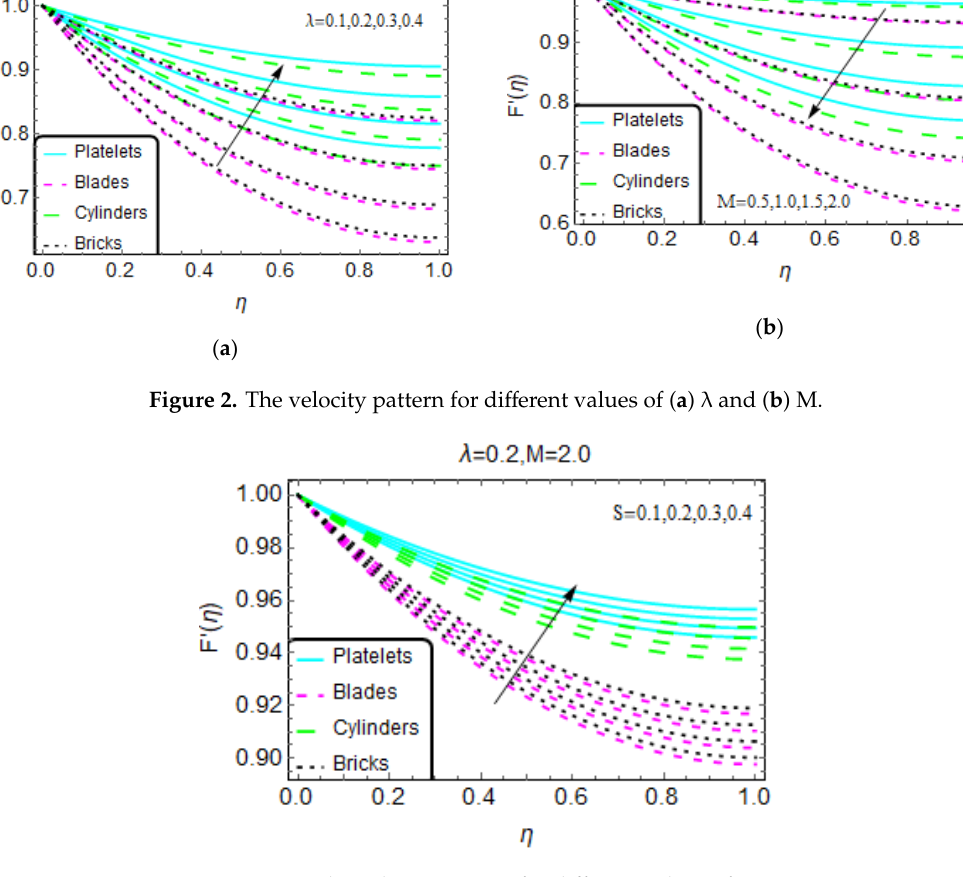
Figure 3. The velocity pattern for different values of S.